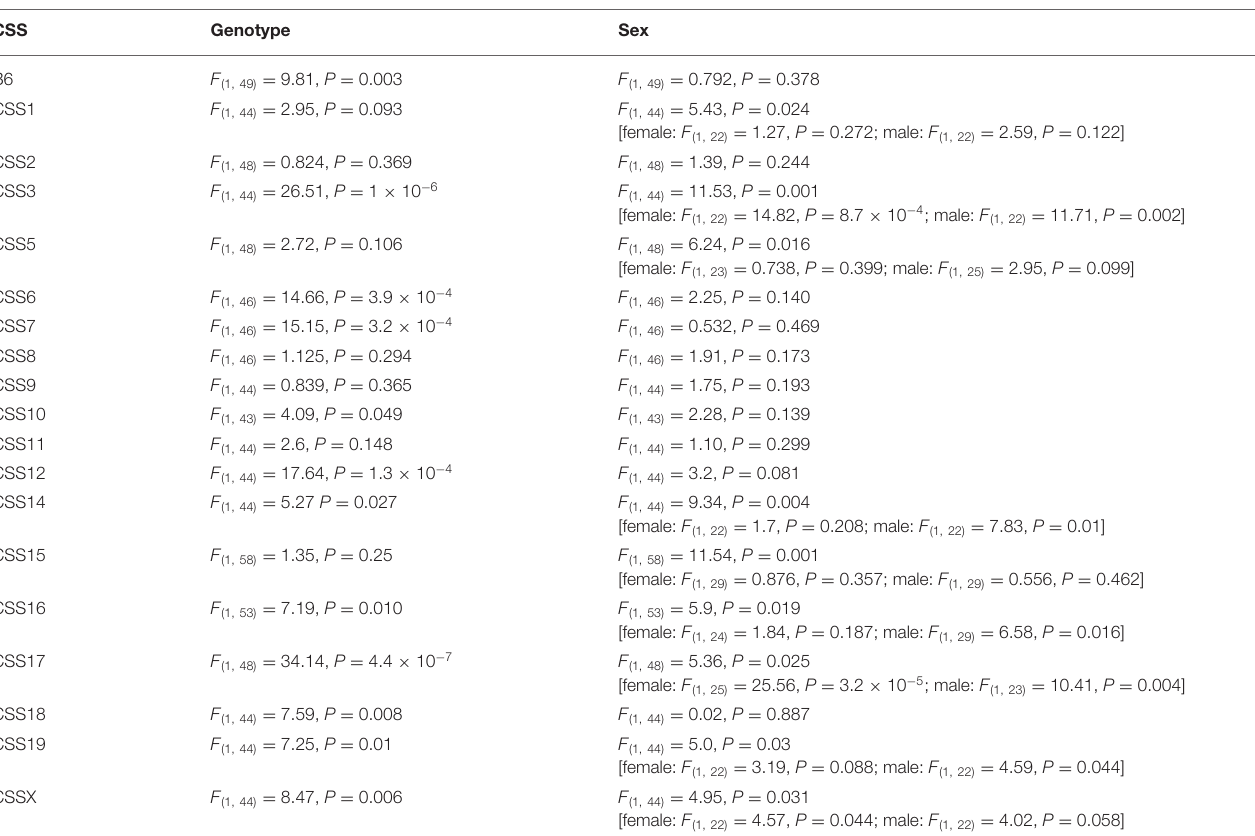
FIGURE 5 | Comparison of nicotine consumption between WT and Chrna5 KO mice for each CSS. Black dotted line indicates mean intake from the B6 WT strain and the red dotted line represents mean nicotine intake from B6 Chrna5 KO mice. * p < 0.05, ** p < 0.01, *** p < 0.005, **** p < 0.001 N = 9–17 per strain per sex. Data represent mean ± SEM. TABLE 3 | Effect of Chrna5 genotype and sex on B6 and individual CSS genetic